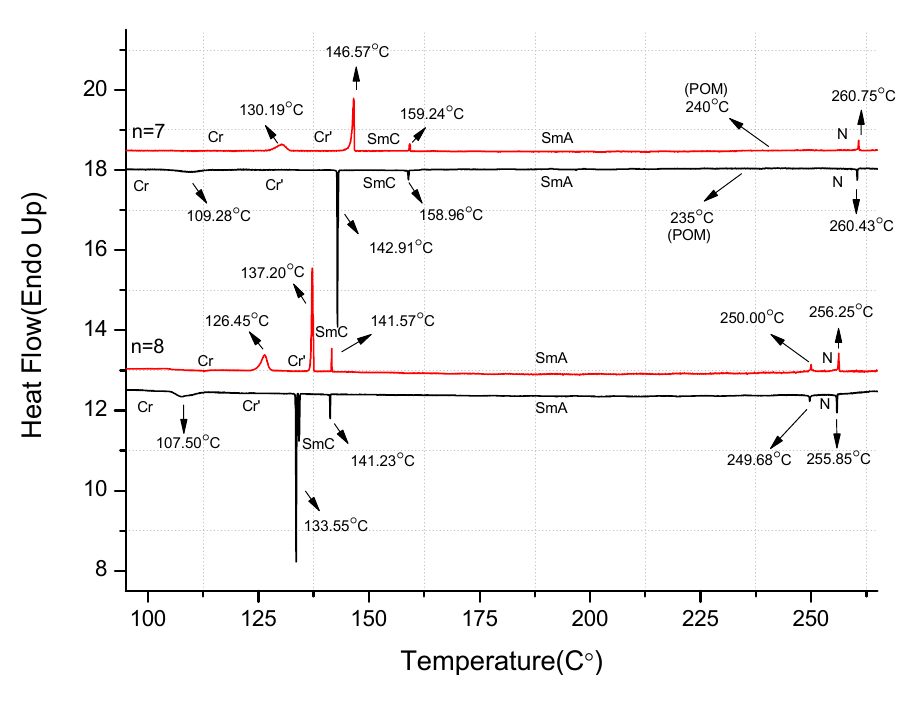
Figure 1. Thermograms of the nO- PPPyCN, n = 7, 8 obtained using a second DSC scan under a heating (red) and cooling (black) rate of 1 °C min − 1 ; Cr, Cr' = crystal phase; SmC = smectic C phase; SmA = smectic A phase; N = nematic phase; I = isotropic